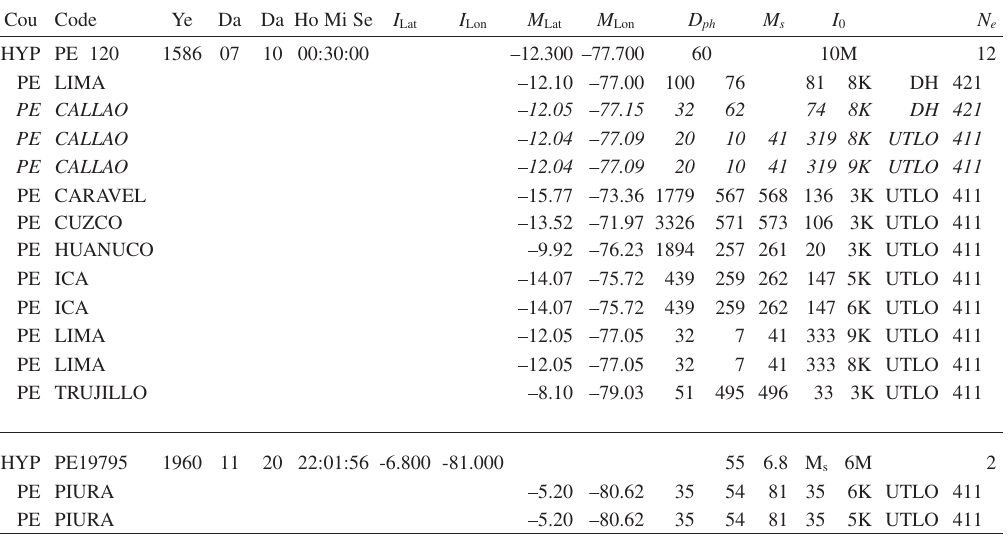
Table II. Example of CERESIS database format. Examples of duplicate record, as for different «interpreter» ( i.e. Callao: DH or UTLO) or uncertainties in the intensity assignment ( i.e. Callao I = 8/9), are